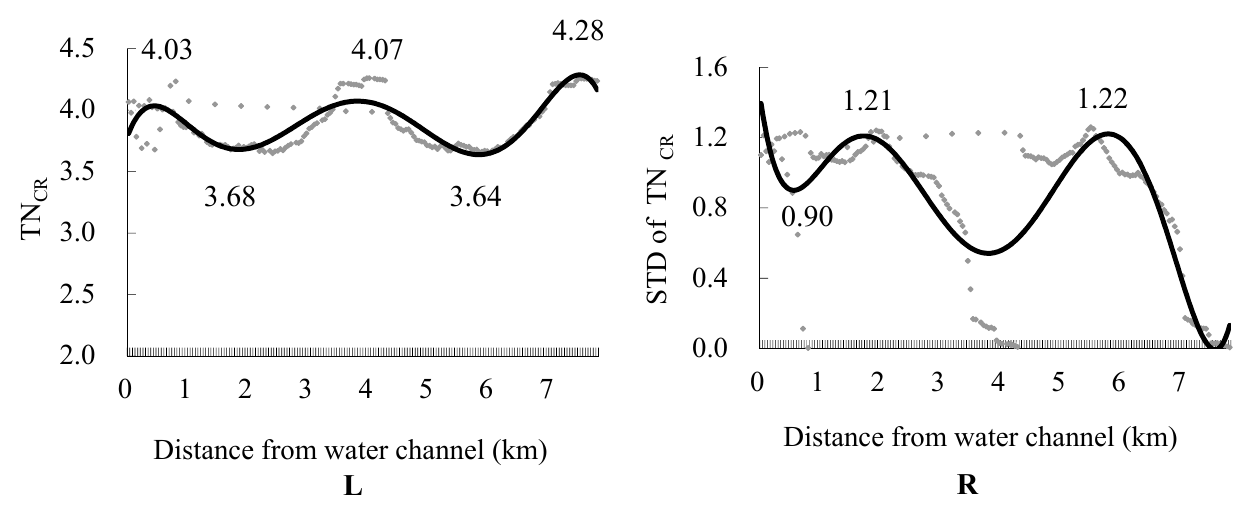
Figure 2. Mean and STD functions of TN CR (dependent index) and distance from the water channel (independent index) during the gradual buffer extrapolation, based on the water channel as a start line in the Sanhuanpao wetland. The curve on the left ( L ) is the mean of TN CR , the curve on the right ( R ) is the STD of TN CR , and the numbers in the figure are the maximum and minimum values of the fitting functions.